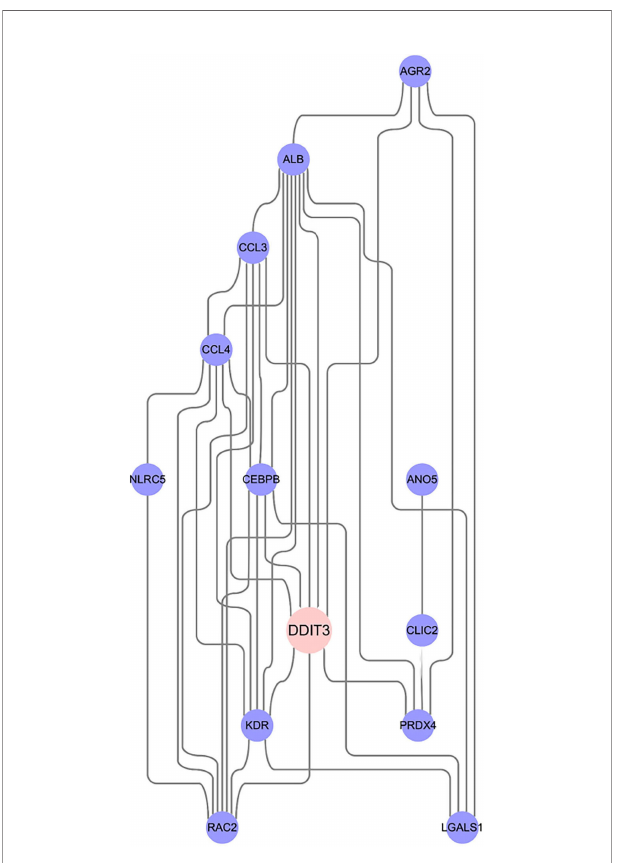
FIGURE 8 | Determine candidate gene according to the PPI network. PPI network diagram of intersection genes.